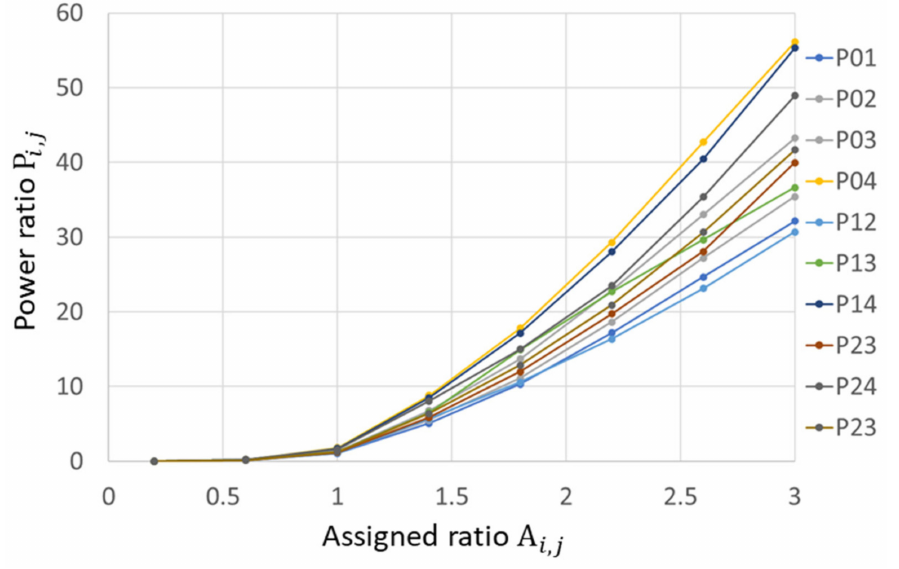
Figure 11. Power ratio simulation for ten cases. The simulation results also show that larger- diffraction-angle separation causes the larger power